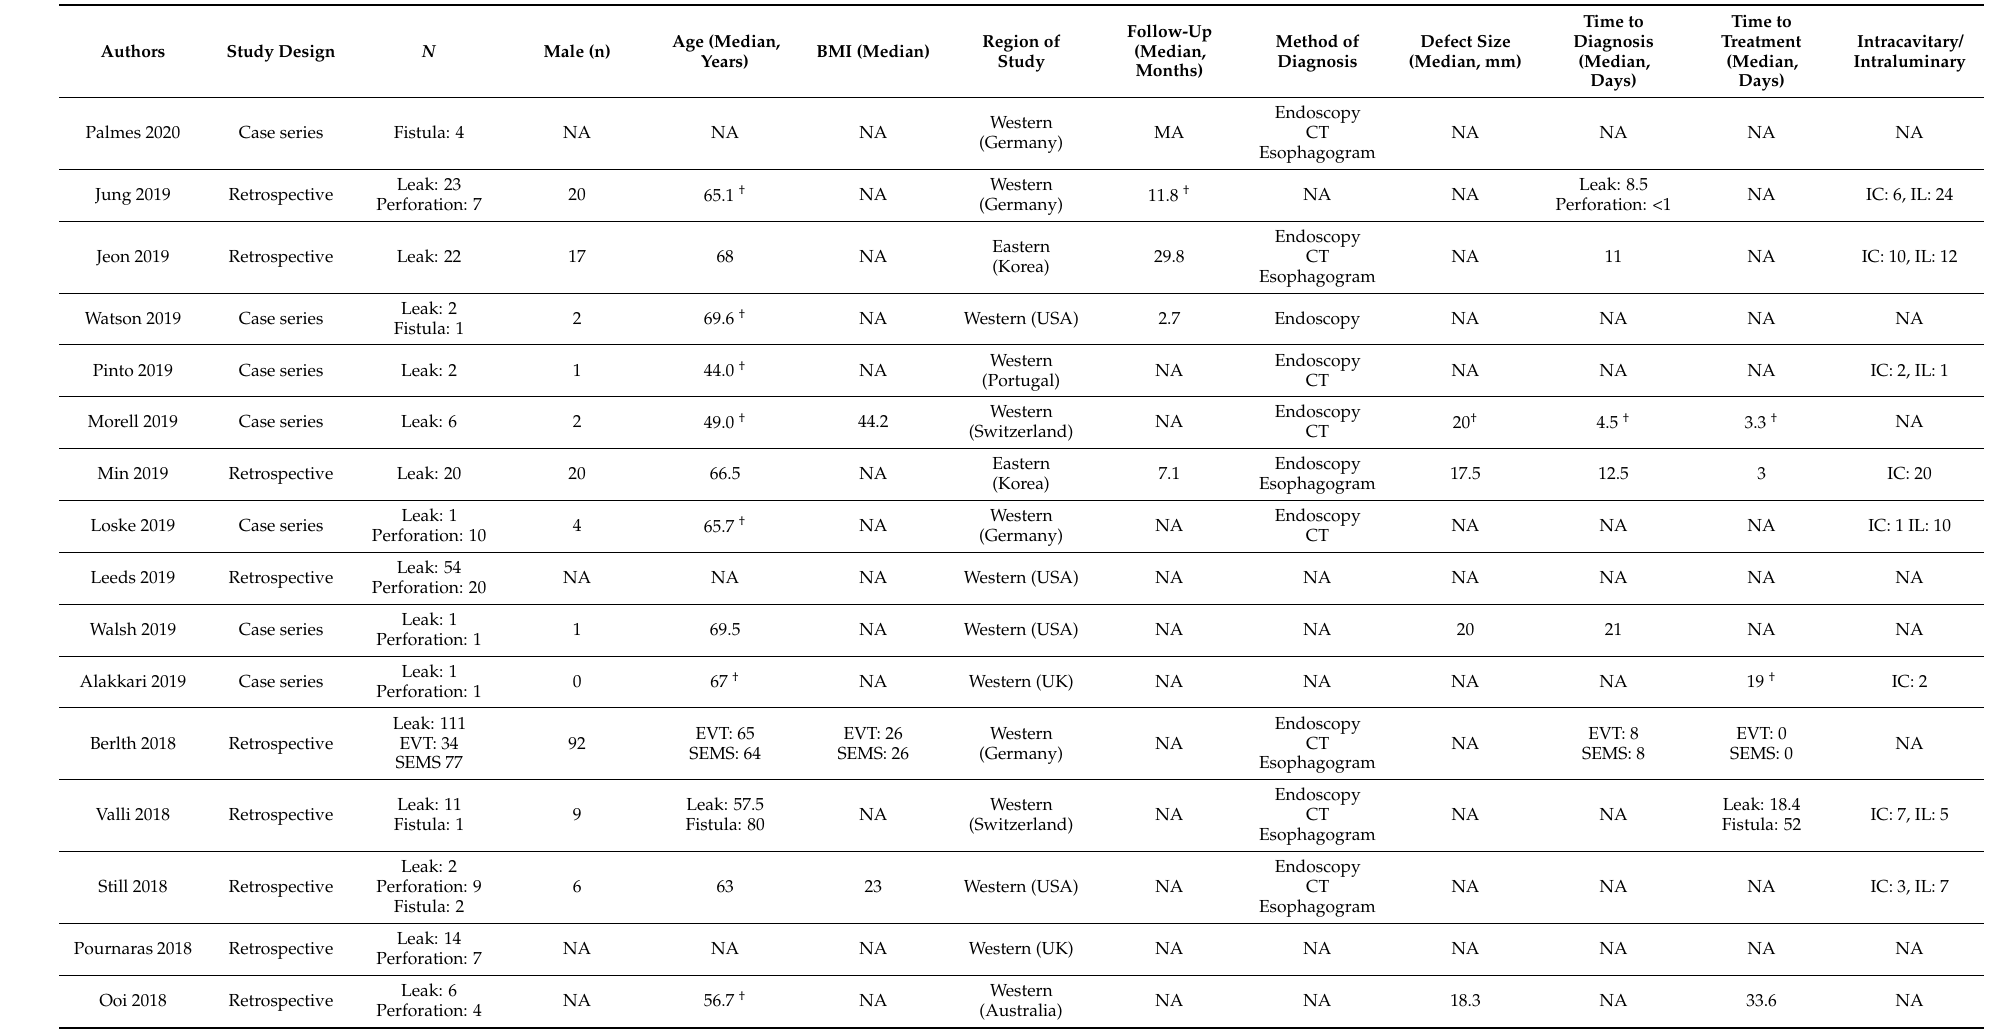
Table 1. Characteristics of 29 studies